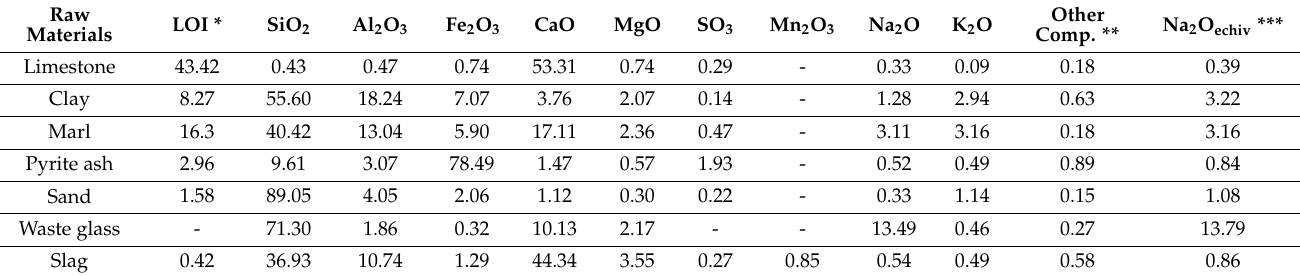
Table 1. Chemical composition (wt %) of raw